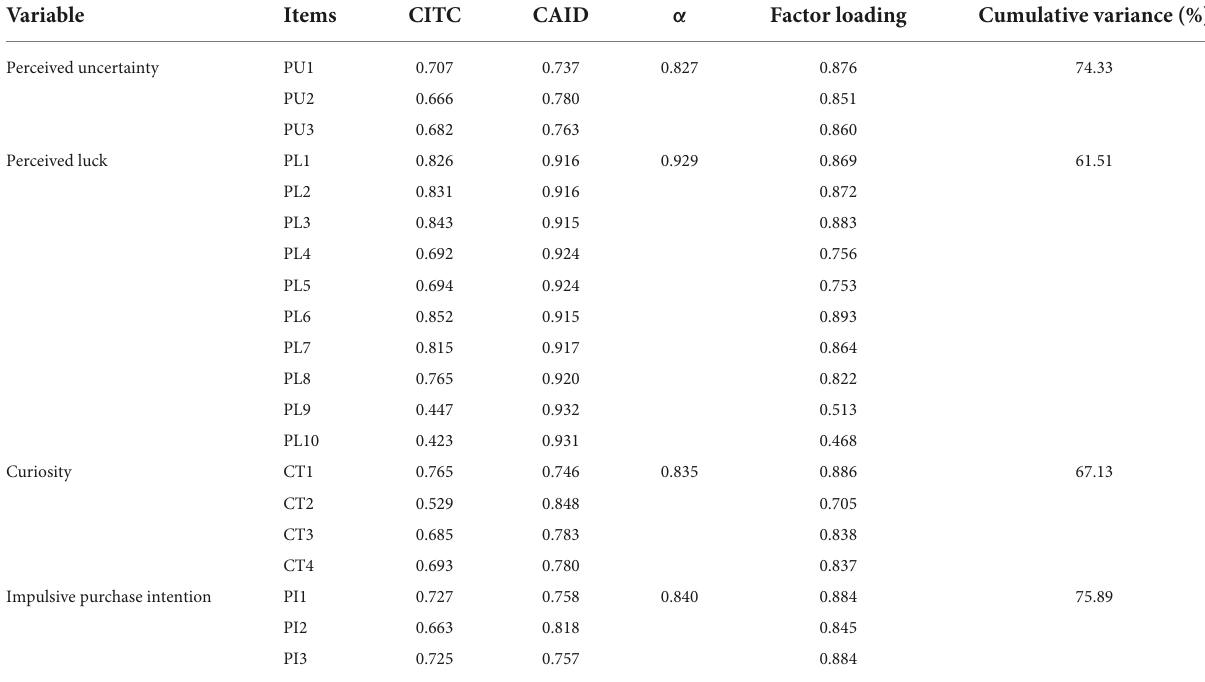
TABLE 1 Reliability and validity tests of the